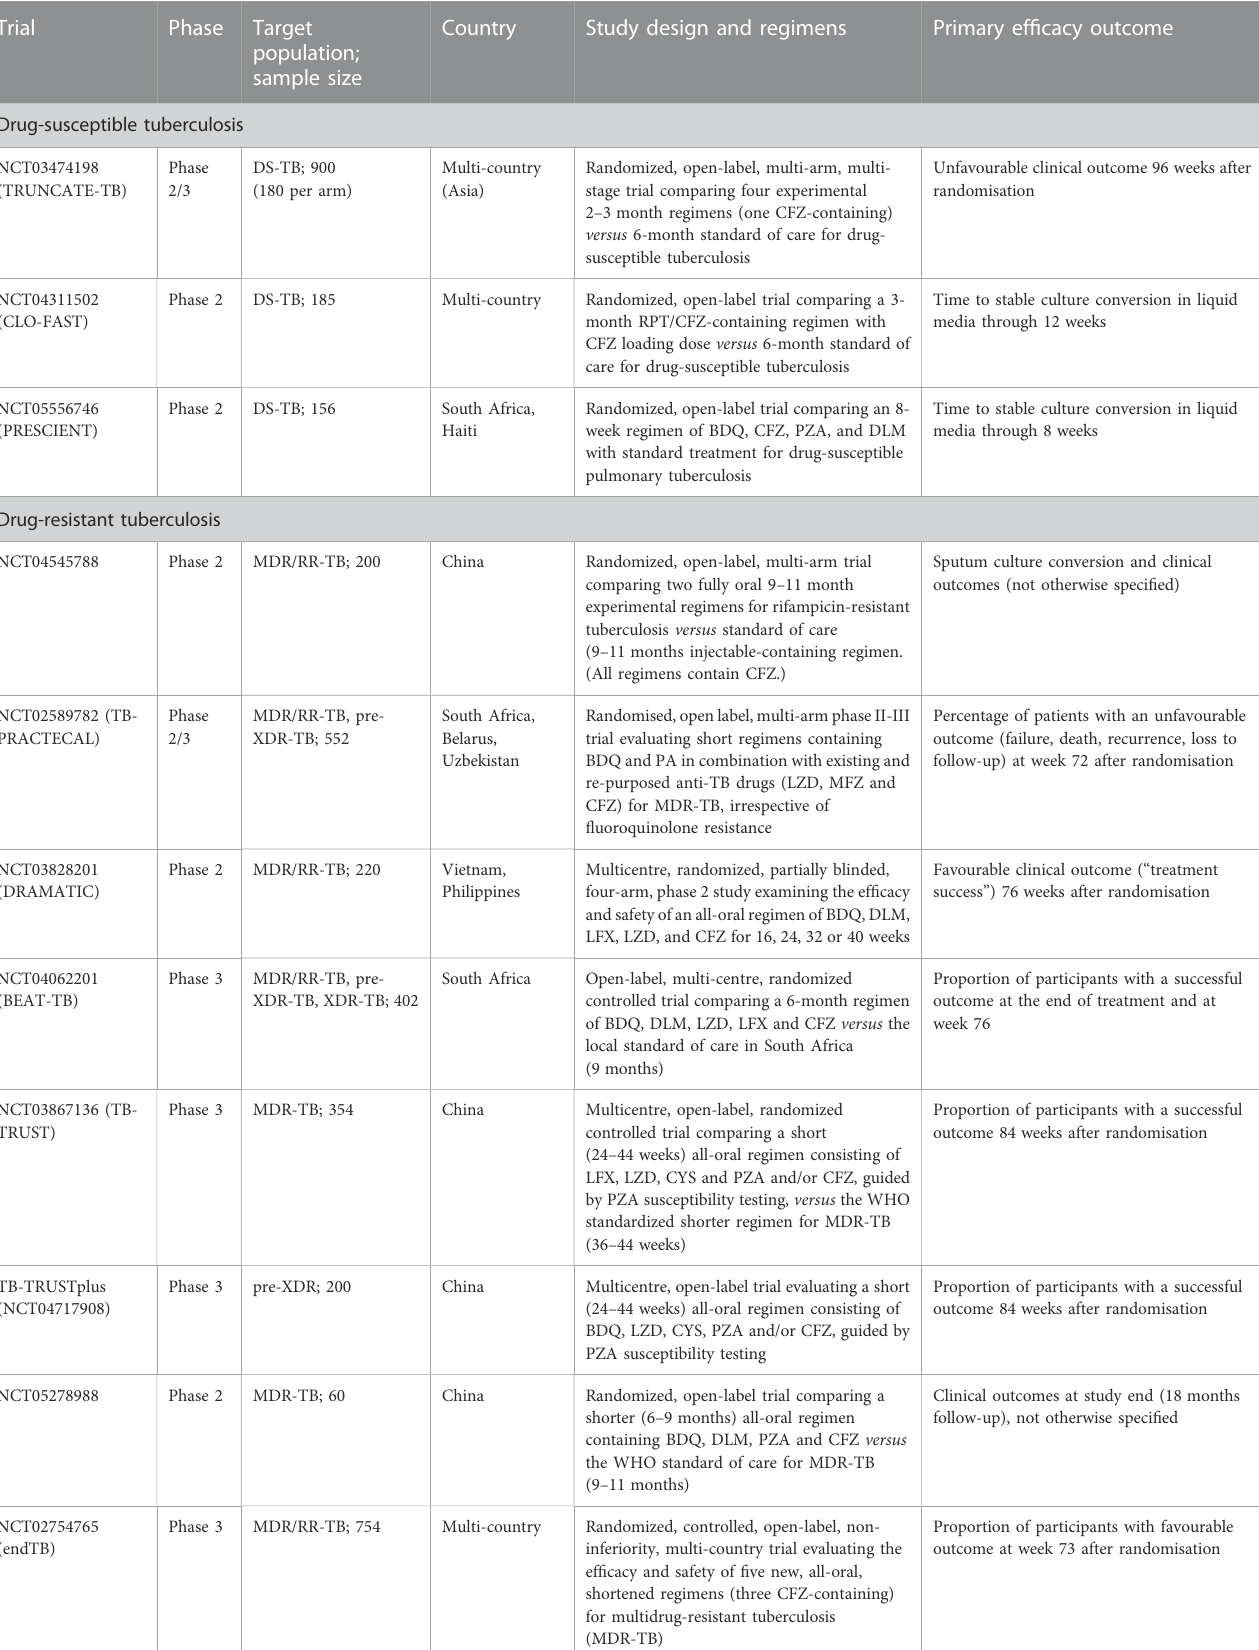
TABLE 2 Ongoing and recently completed clinical trials evaluating clofazimine-containing shorter regimens for drug-susceptible and -resistant